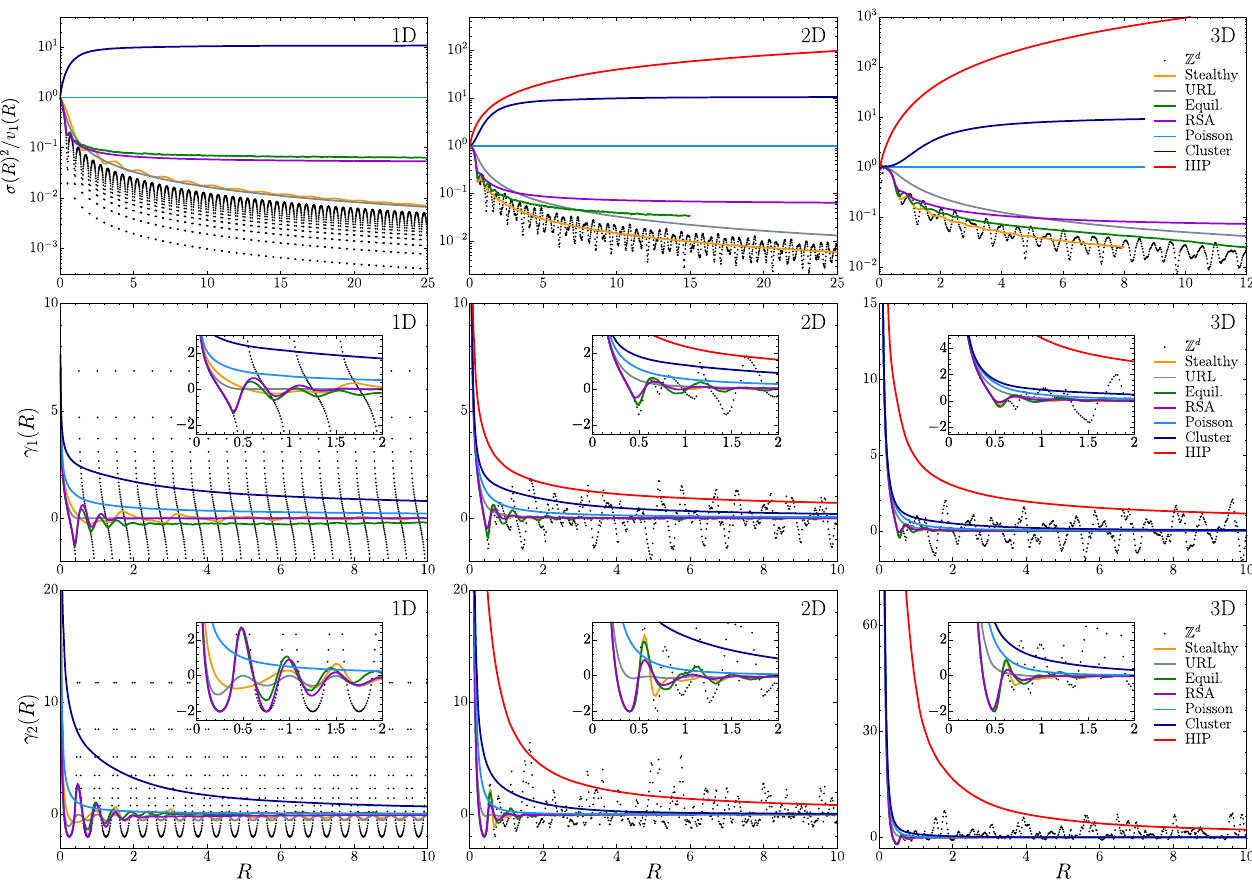
FIG. 2. Graphs of the number variance, skewness, and excess kurtosis versus the window radius R for all considered models across the first three space